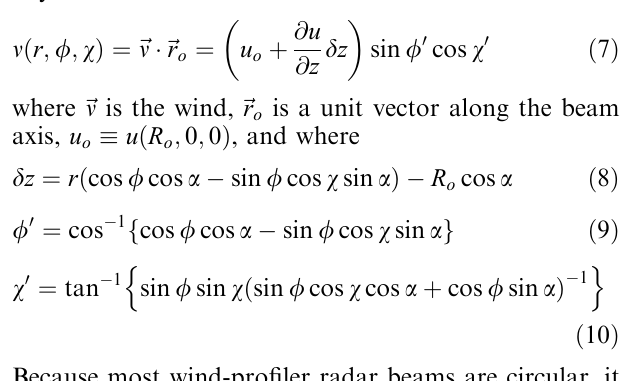
Fig. 1. The component of the wind along the beam at